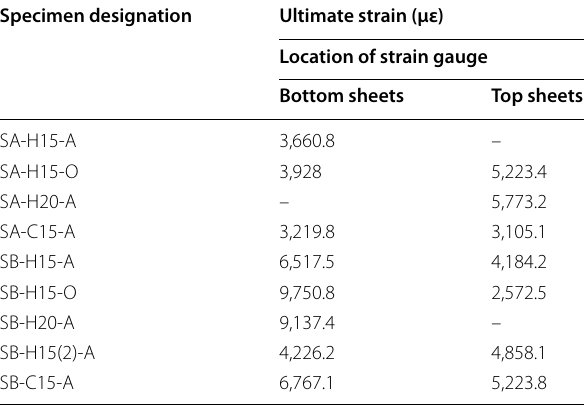
Table 5 Measured (HFRP‑CFRP) ultimate